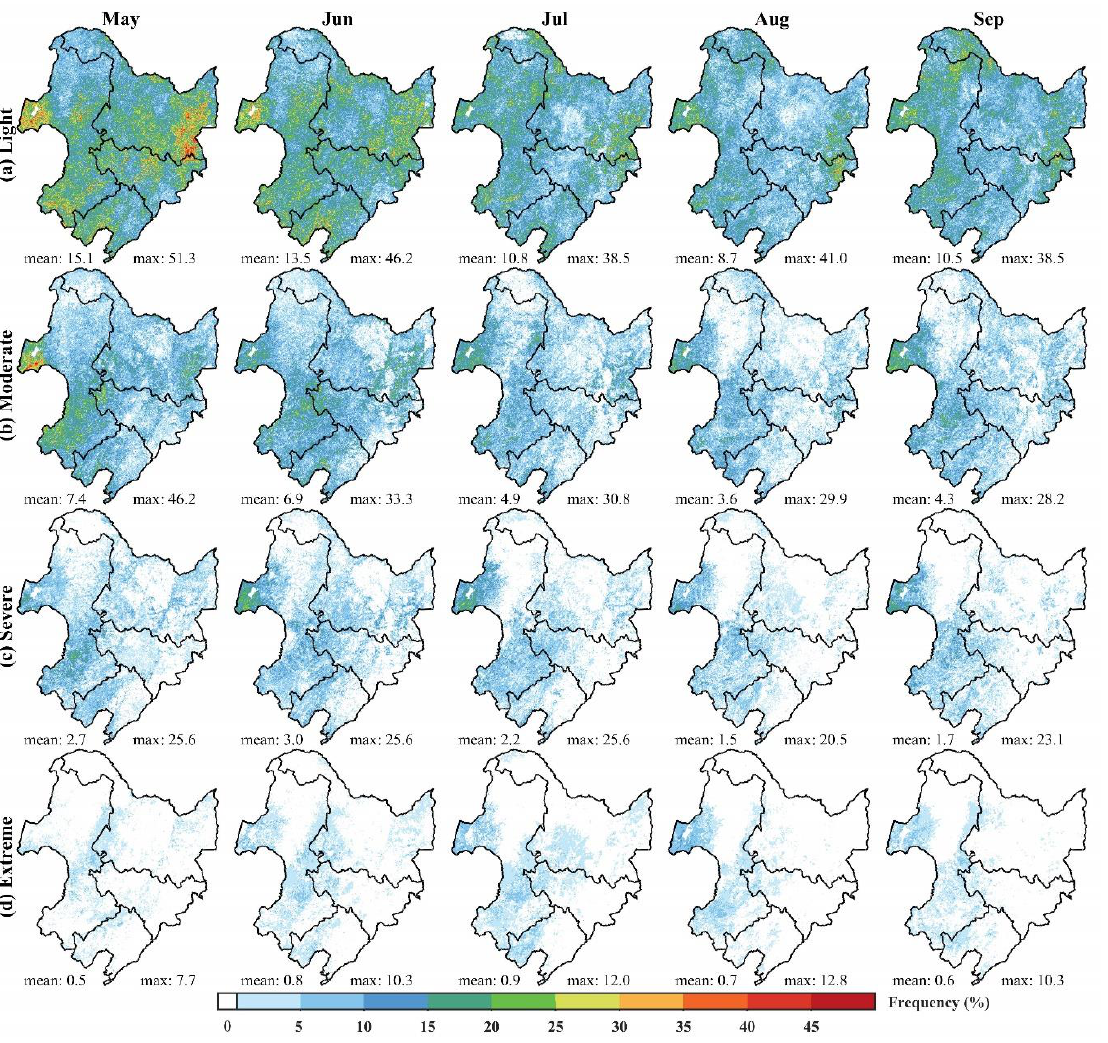
Figure 8. Spatial pattern of different drought level frequencies based on the CDI in the growing season of NEC from 1982 to 2020.